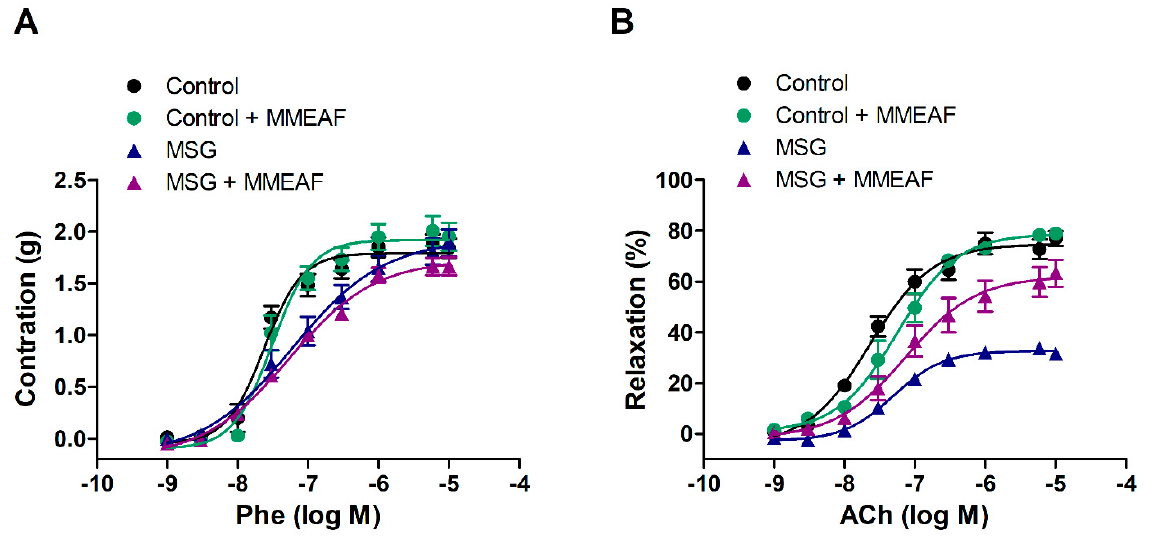
Figure 7. Effects of MMEAF on vascular reactivity to Phe ( A ) and ACh ( B ) in control and MSG aortic rings. Results are mean ± S.E.M of 5–6 experiments. Table 4. Half maximal effective concentration (pEC 50 ) and maximal effect (E max ) of Phe and ACh.